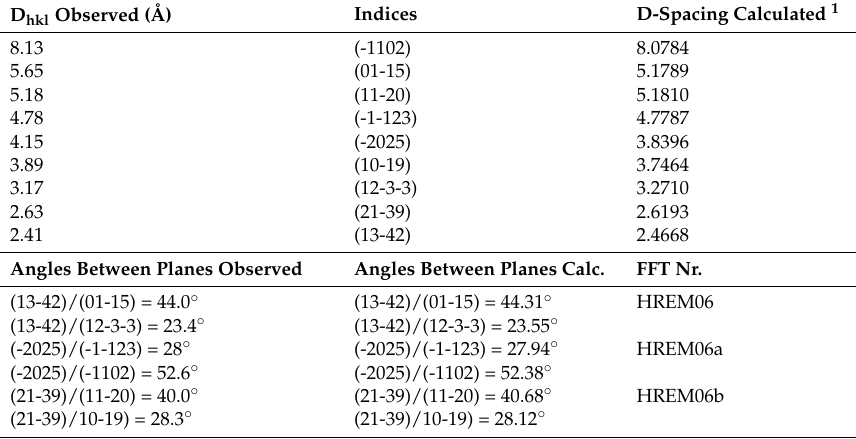
Table 1. Crystallographic data of